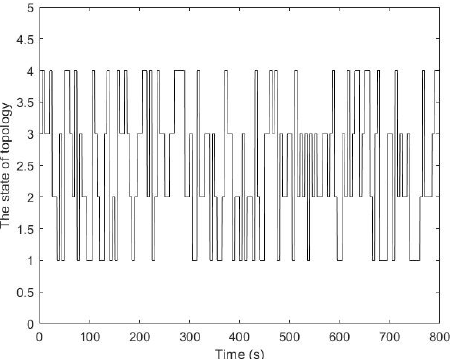
Figure 3. The first 800 s of Markov-switching topology states.